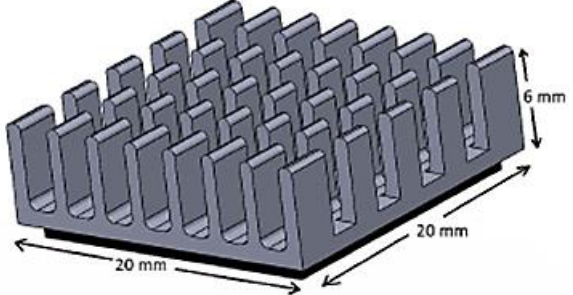
Figure 2. Heat sink used in the experimental setup.